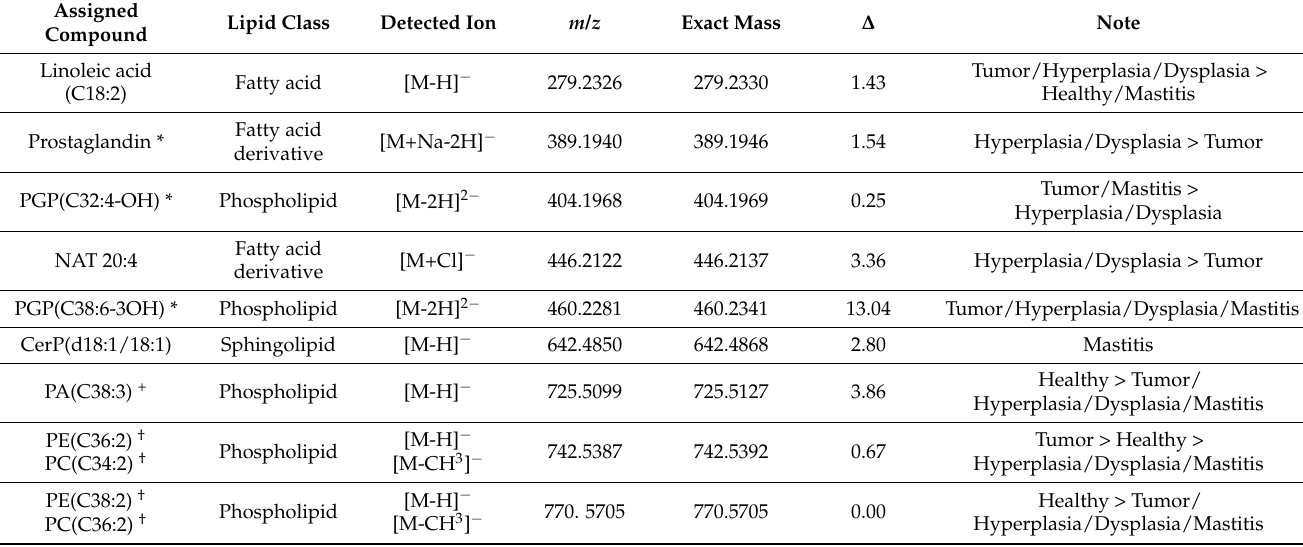
Table 2. List of discriminant features according to the PC2 loading plot, along with the calculation of the mass error ( ∆ ) resulting from the difference between the theoretical mass (Exact Mass) and the observed m / z value, and a note about the statistical class in which it was mainly detected and/or quantitative comparison. * oxidized species. For the m / z value 389.1940, different compounds (keto, hydroxyl, epoxy), characterized by the same exact mass and all belonging to the prostaglandin class, were generated into the humane metabolome database. Similarly, the oxidized phosphatidylglycerol phosphate (PGP) species can contain different oxidation products of arachidonic acid, including prostaglandins. + confirmed by the literature [24]; † confirmed by the literature